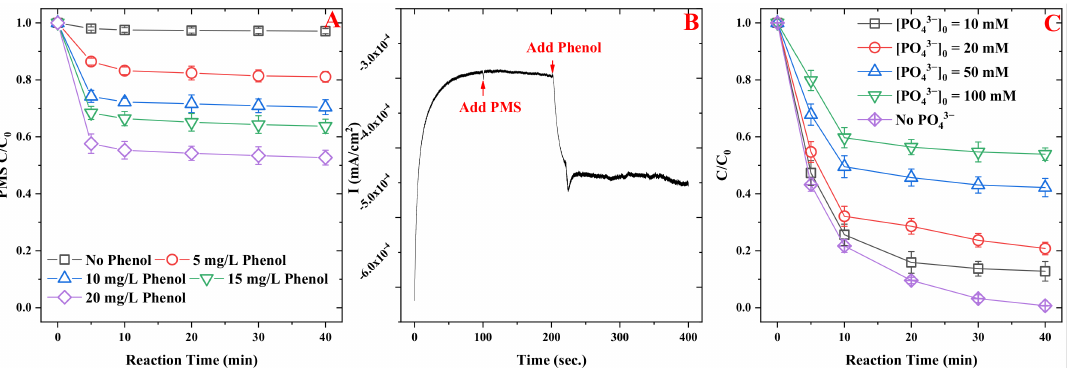
Figure 3. Decomposition of PMS in the presence of various concentrations of phenol ( A ), i-t curve of α -MnO 2 ( B ), degradation of phenol in the presence of higher concentration of PO 43 − ( C ). Re- action conditions: [ α -MnO 2 ] 0 = 0.2 g/L, [PMS] 0 = 1.5 mM, [phenol] 0 = 0–20 mg/L, pH 0 = 7.0, [PO 43 − ] 0 = 0–100 mM Temperature = 30 ◦